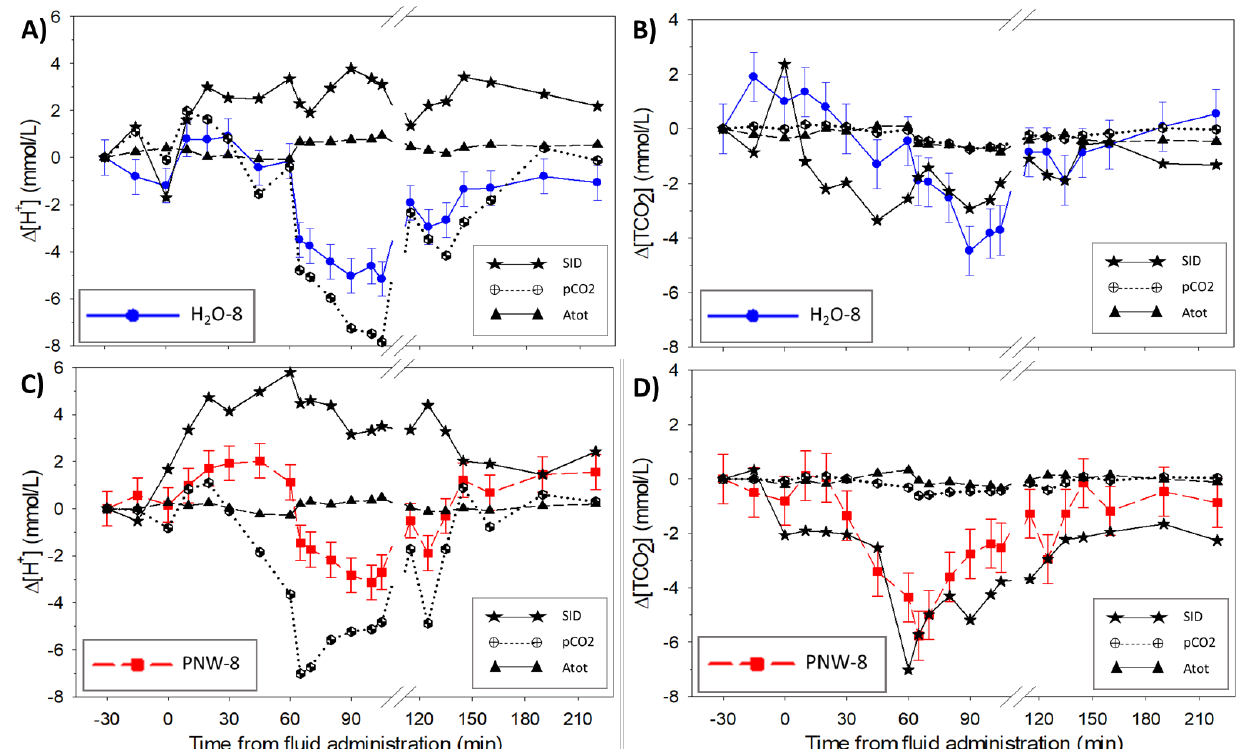
Figure 7. Contribution of the independent variables to the changes in plasma [H + ] ( A , C ) and [TCO2] ( B , D ). n = 4 horses were administered, in a randomized crossover design, 8L of water as a control (H2O-8; A and B) or 8L of a balanced, hypotonic oral electrolyte solution (PNW-8) 60 min before they exercise on a treadmill at 50% of peak VO2 for 45 min. The independent variables contributing to acid-base state are [SID], strong ion difference; pCO2, partial pressure of carbon dioxide; and [Atot], total weak acid concentration.